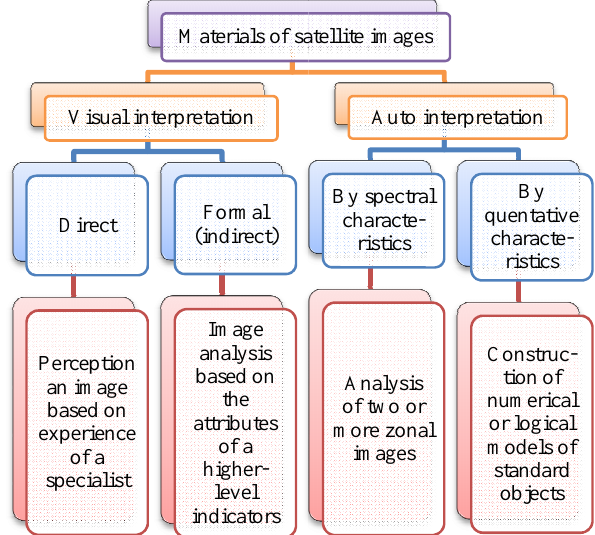
Figure 2. Technological scheme